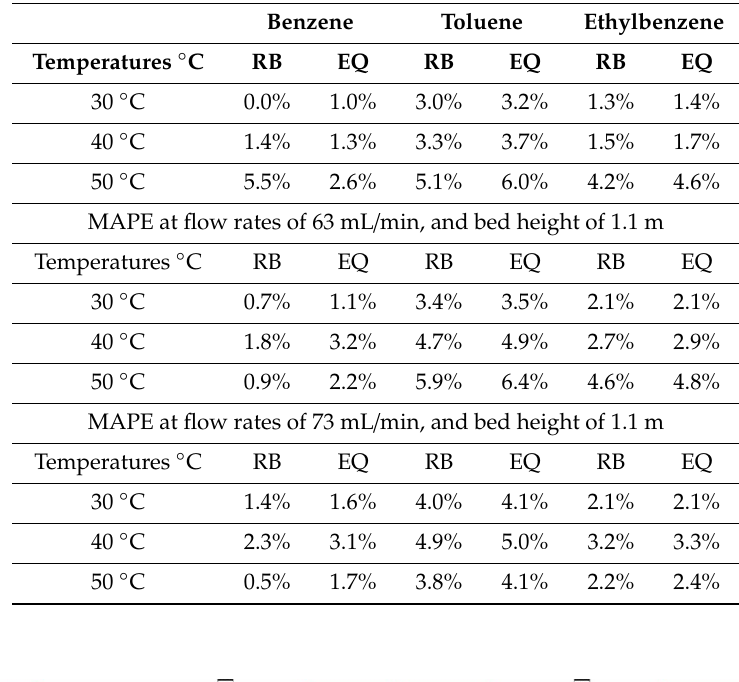
Table 8. MAPE between the values calculated using the models (RB and EQ) and those obtained from empirical measurement at a bed height of 1.1 m.